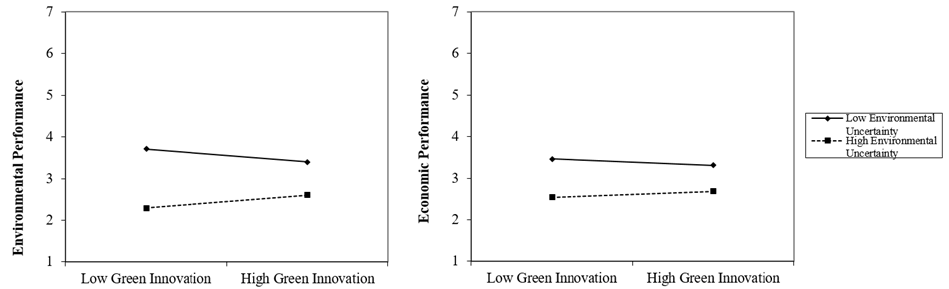
Figure 4. Moderation effects.